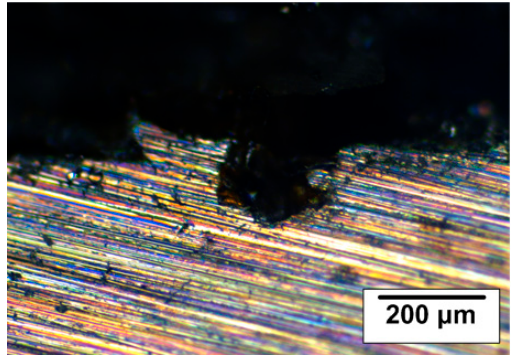
Figure 8. Cross-sectional image of the α -FeOOH-covered specimen after potentiostatic tests under − 650 mV SCE for 20 h in the simulated district heating water at 40 °C.